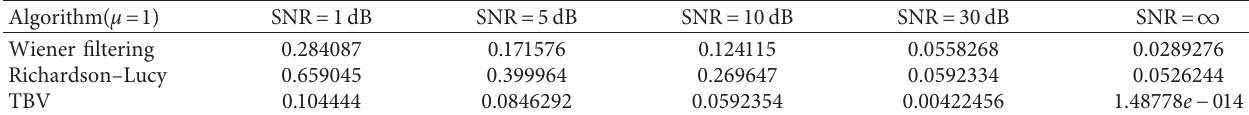
Table 1: MSE of the restored signal and the original signal (different